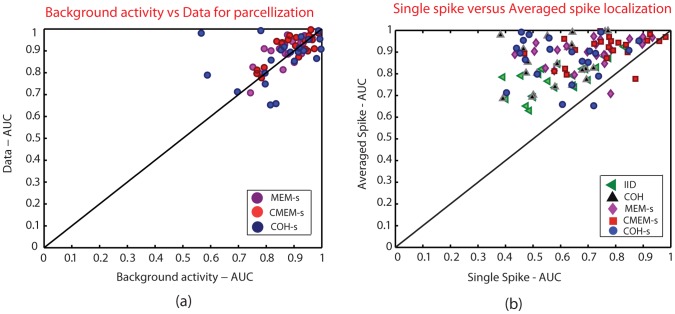
Comparison of detection accuracy AUC.Plot showing the (a) effect of background activity versus data of interest for the parcellization: MEM-s (purple), CMEM-s (red) and COH-s (blue) (x-axis: AUC value for Baseline, y-axis: AUC value for data), and (b) effect of single spike localization versus average spike localization: IID (green), COH (black), MEM-s (purple), CMEM-s (red) and COH-s (blue) (x-axis: AUC value for single spike localization, y-axis: AUC value for averaged spike localization).